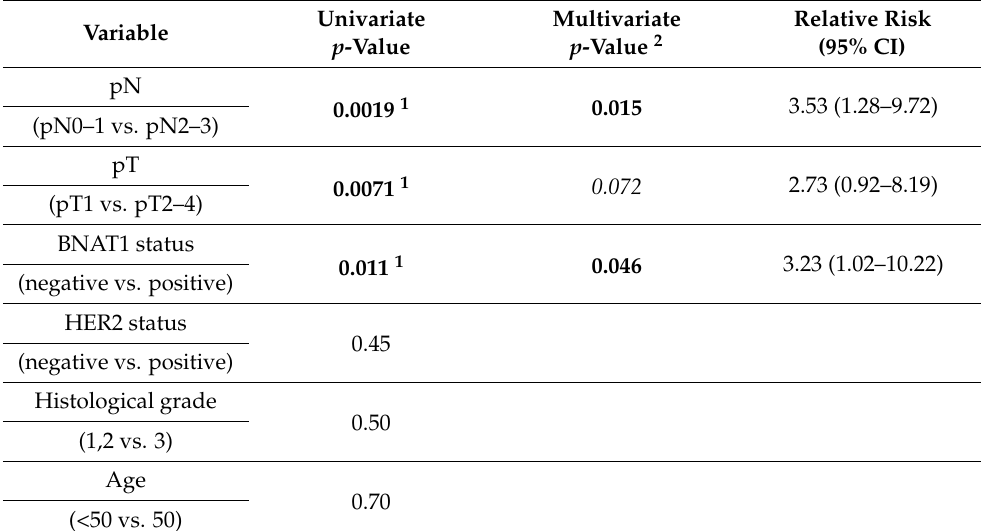
Table 4. Univariate and multivariate analyses of distant disease-free survival in 115 ER-positive breast cancer